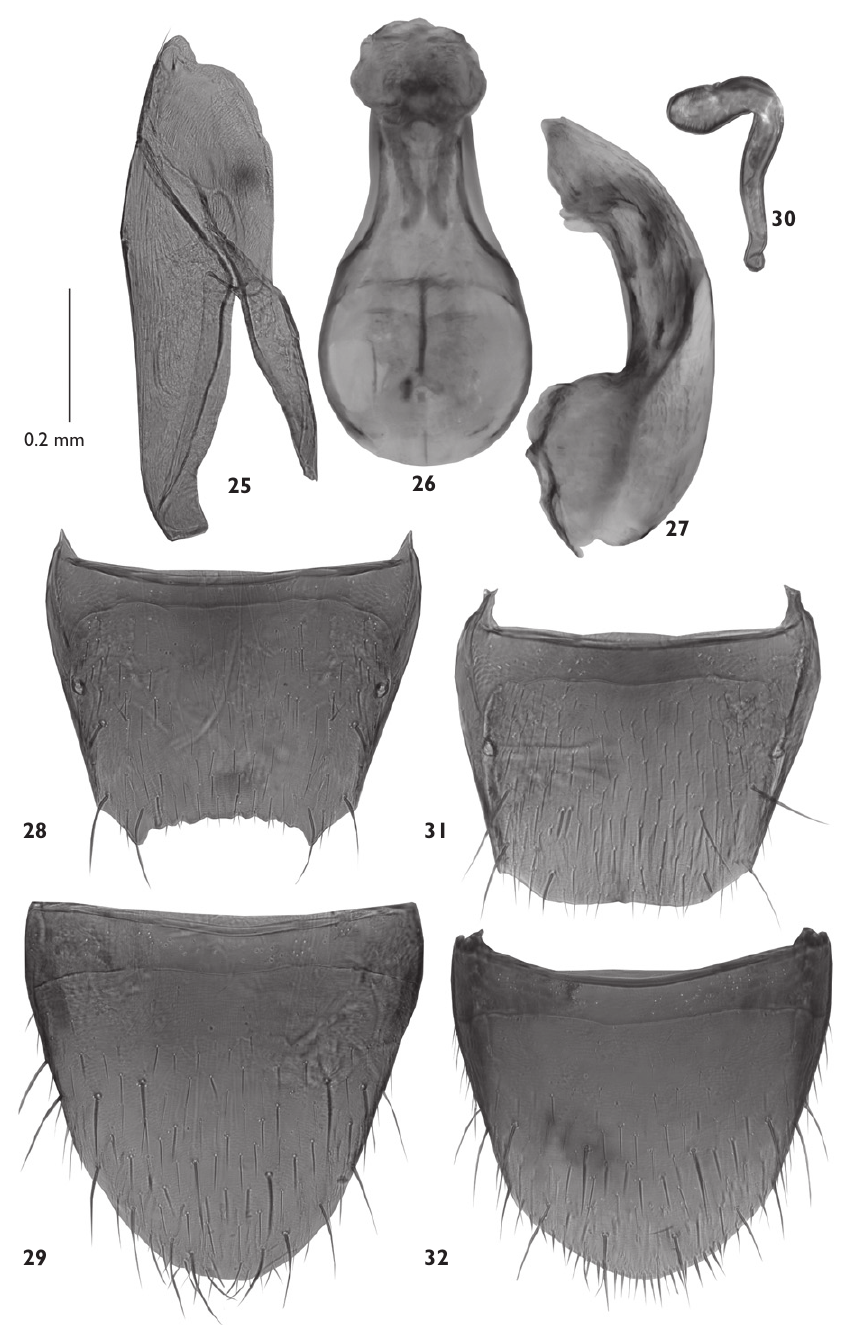
Figures 25–32. Schistoglossa pseudocampbelli : 25 paramere 26 median lobe of aedeagus in dorsal view 27 median lobe of aedeagus in lateral view 28 male tergite 8 29 male sternite 8 30 spermatheca 31 female tergite 8 32 female sternite